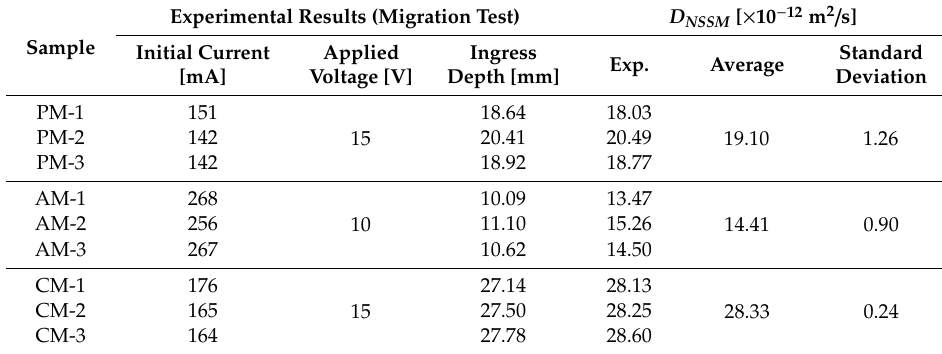
Figure 8. Results of natural chloride diffusion test: total and free chloride content of ( a ) PM, ( b ) AM and ( c ) CM; ( d ) Relationship between the total and free chloride content of the samples. Table 6. Experimental results of the non-steady state chloride migration (NSSM) test.